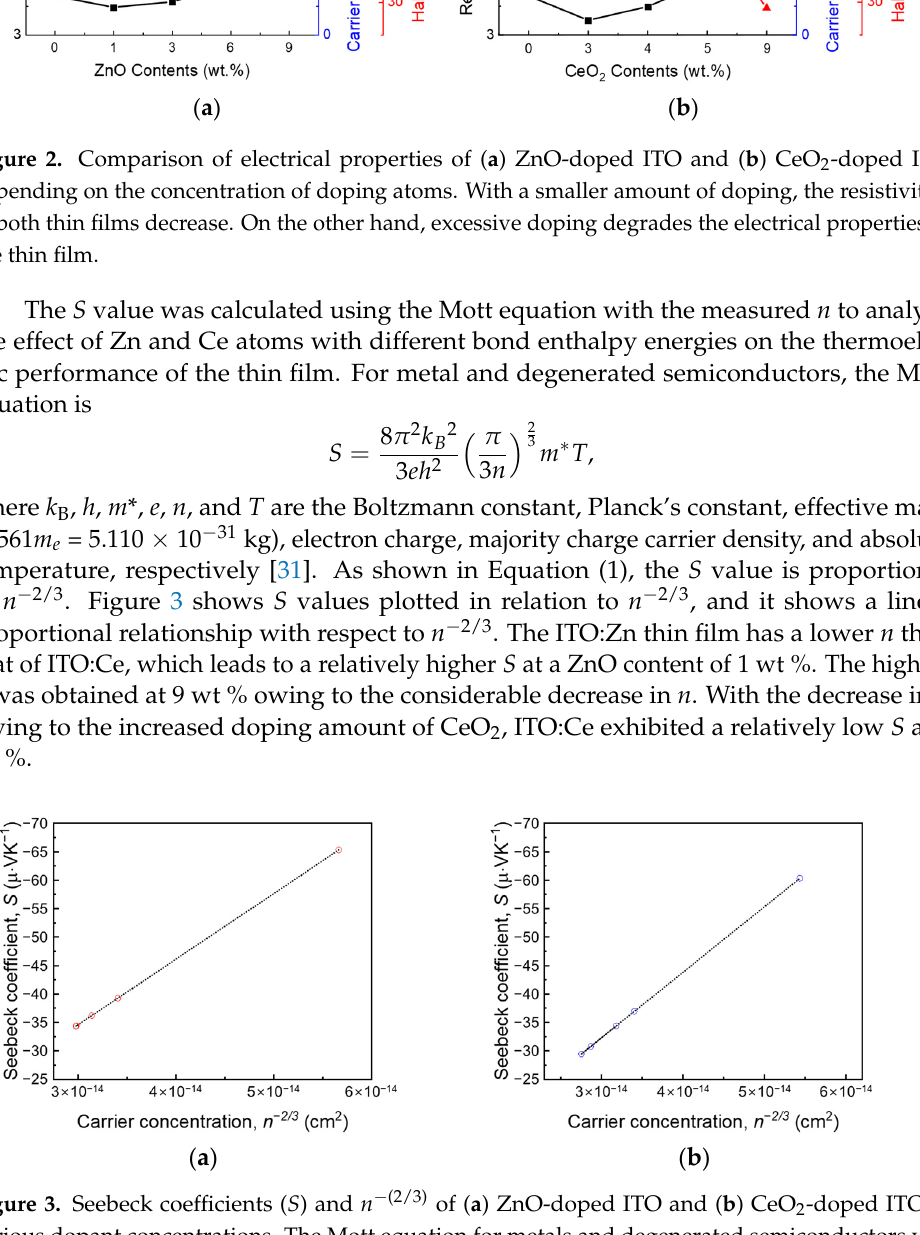
( c ) Figure 4. Dependence of the thermal conductivities of the ( a ) ZnO-doped ITO and ( b ) CeO 2 -doped ITO on the doping concentration. ( c ) Thermoelectric figures of merit (ZT) of ZnO- and CeO 2 -doped ITO. The lattice thermal conductivity increased above a certain doping concentration. However, an abnormal phenomenon of κ l increase above certain dopant concentra- tions was observed for both ZnO- and CeO 2 -doped ITO. As mentioned previously, the impurity doping in thin films causes disordered crystallinity, which deteriorates κ l . There- fore, κ l should also be decreased; however, above a certain concentration, κ l is slightly increased. We propose two hypotheses to explain the κ l increase: (1) metal hydroxide for- mation and (2) localization of excessive dopant atoms.